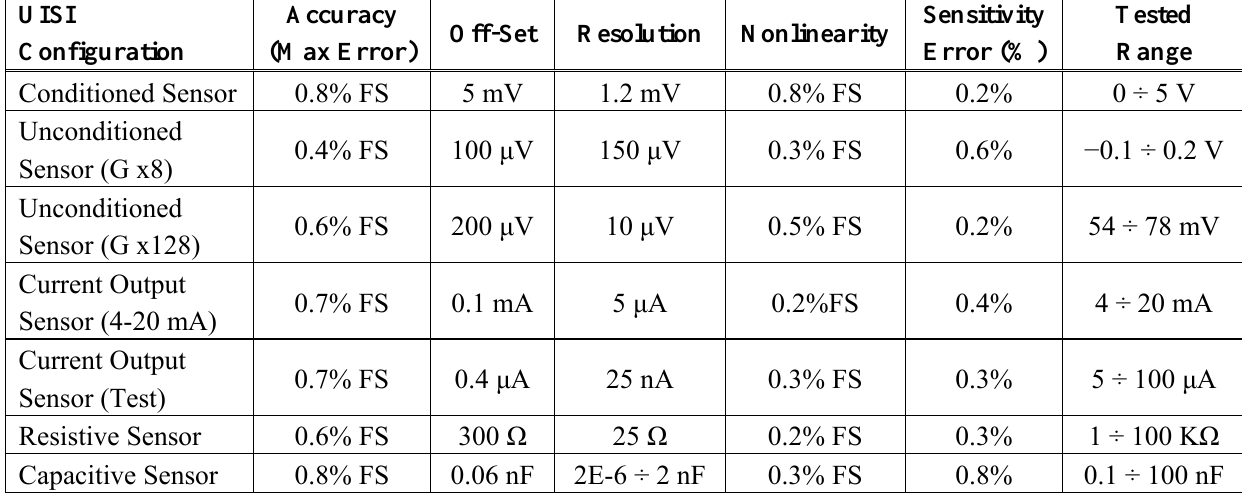
Table 3. Summary of UISI characterization results for the different sensor